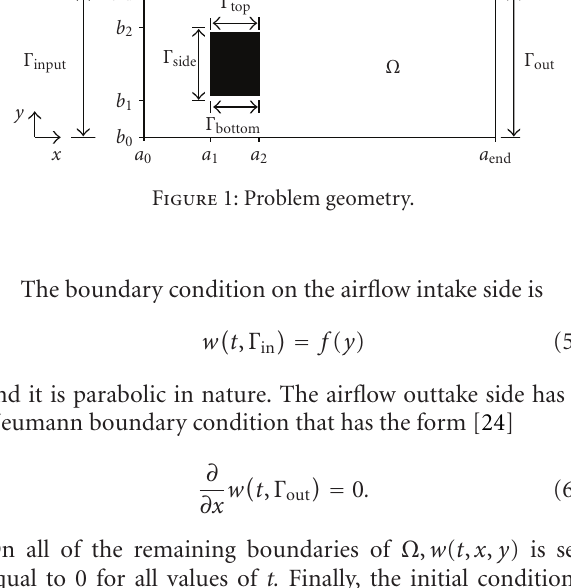
Figure 2: Test inputs used to generate the